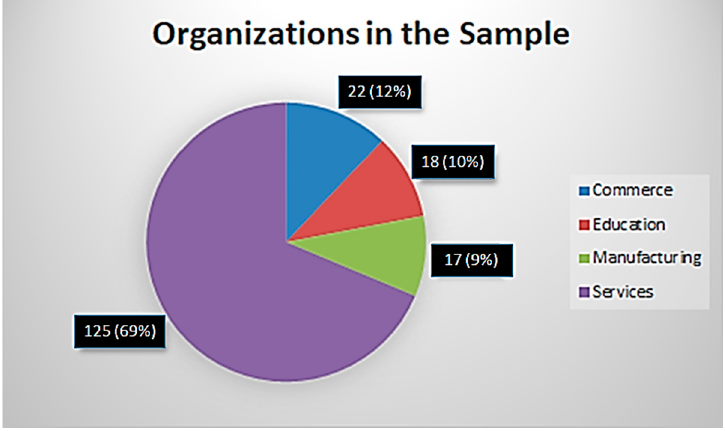
Figure 3. Sample composition and distribution (frequency and percentage).